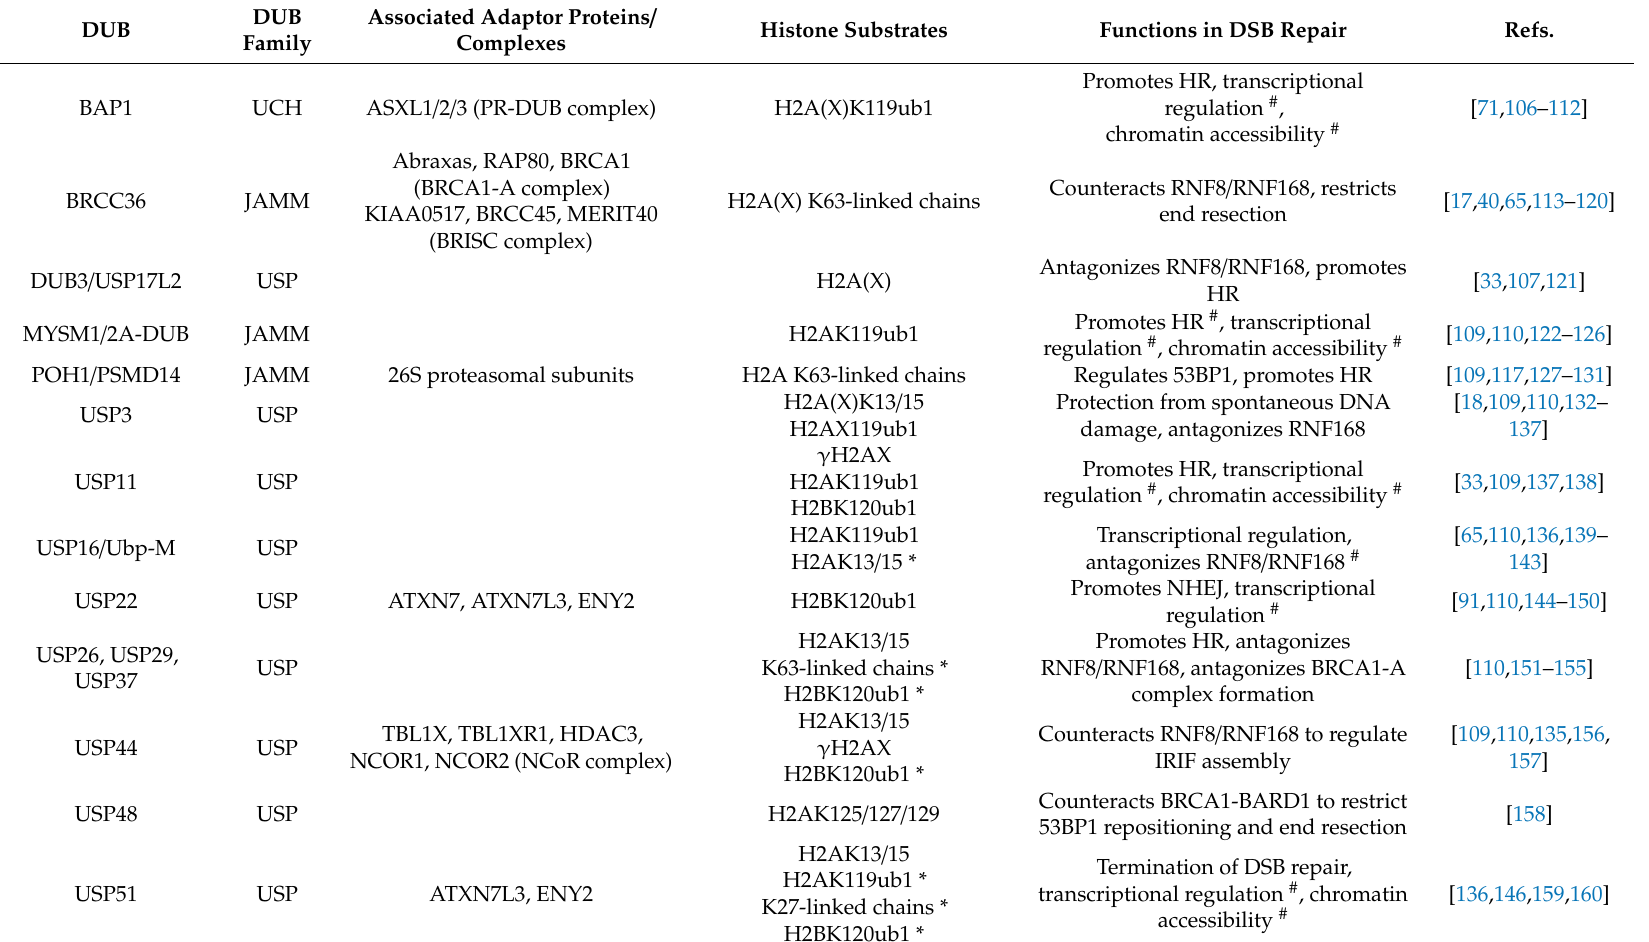
Table 1. Histone-modifying DUBs, the complexes they form, and their putative roles in the repair of